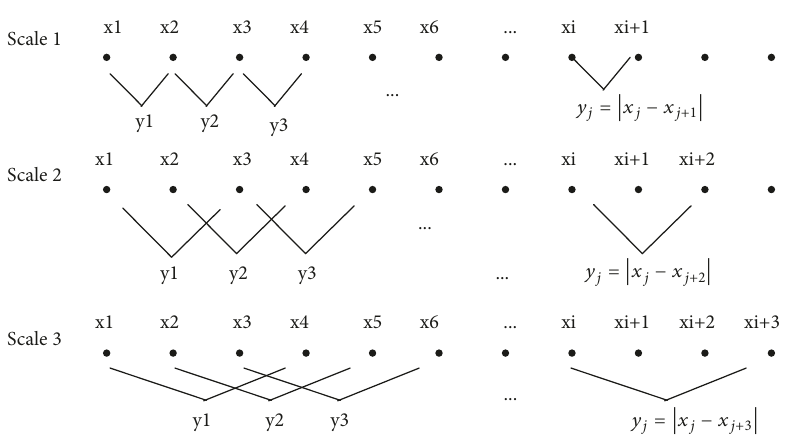
Figure 1: (a) ictal EEG, (b) interictal EEG, (c) normal EEG.